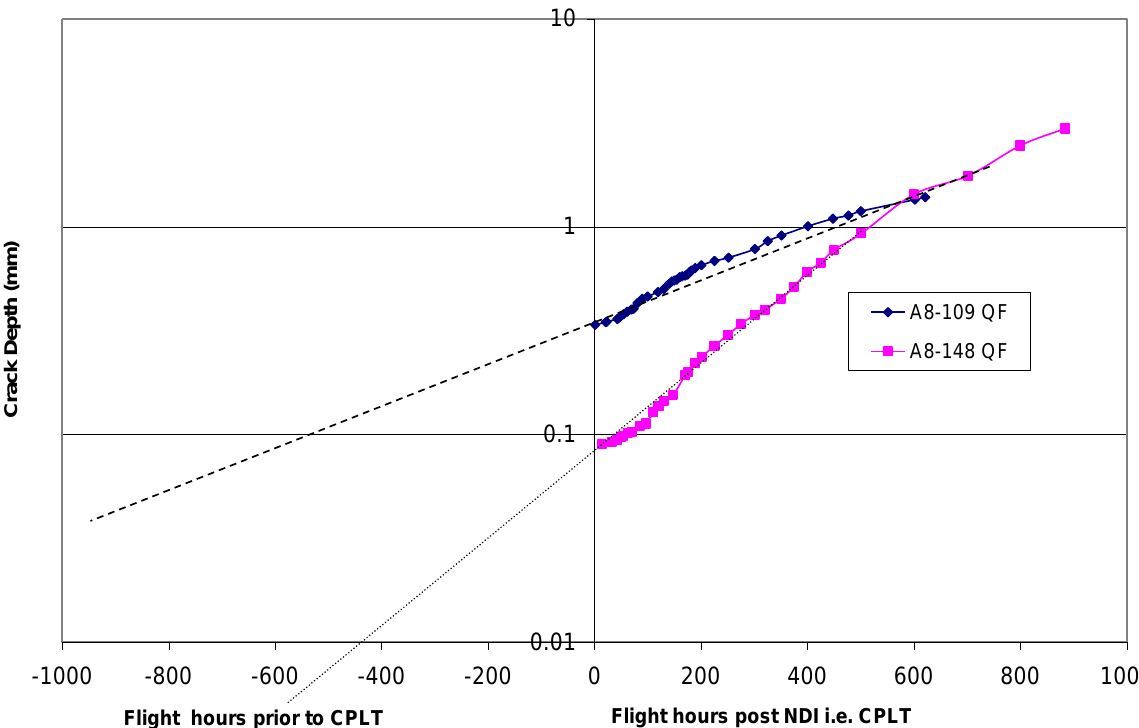
Figure 16. QF-derived and back-extrapolated crack growth curves for the aircraft A8-109 and A8-148 stiffener runouts, adapted from [48].